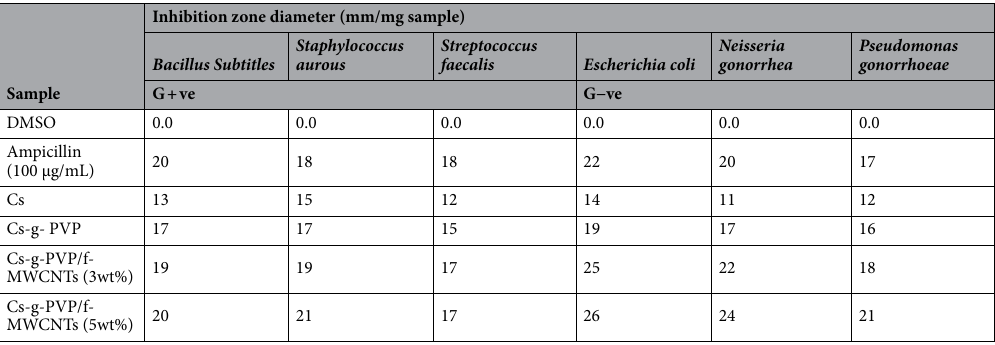
Table 3. The antimicrobial activities of the investigated samples against some G + ve and G -ve bacterial strains.